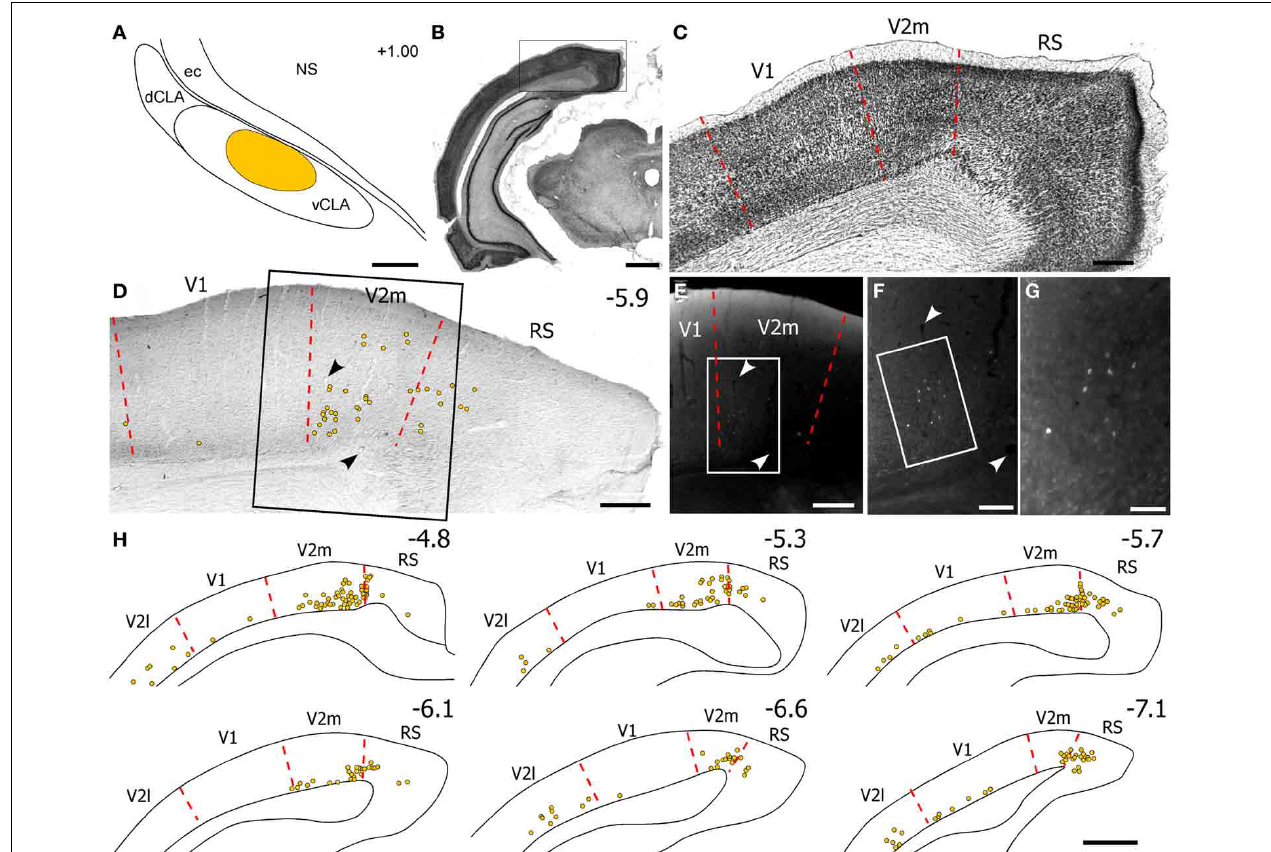
FIGURE 5 | Few neurons in visual cortex project to the claustrum. (A) Reconstruction of an FG deposit in claustrum depicted in Figure 9 of Smith and Alloway (2010). (B,C) Nissl-stained section through primary visual (V1), medial secondary visual (V2m), and retrosplenial cortices. (D) Plotted location of FG-labeled neurons in an adjacent